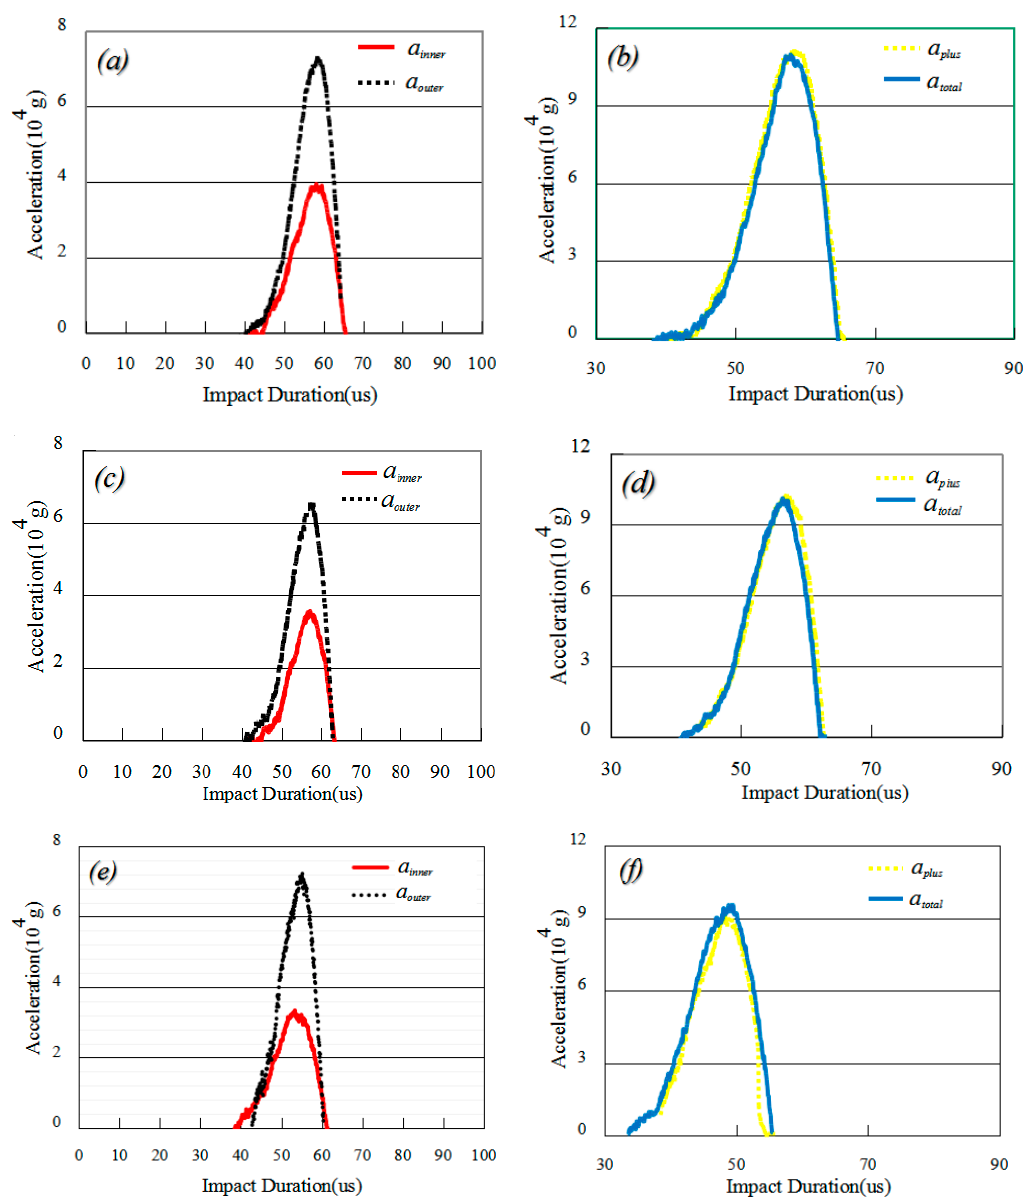
Figure 5. Experimentally determined accelerations under impacts from the inner ( a inner , solid lines ) and outer ( a outer , dotted lines ) bullets as functions of impact duration, as detected by the Doppler frequency shift of the mounted base. ( a ), ( c ), and ( e ) show the cases impacted by the bullets separately; ( b ), ( d ), and ( f ) show the cases impacted by both bullets simultaneously ( a total , solid lines ). The dotted lines in ( b ), ( d ), and ( f ) represent the sums of the accelerations ( a plus ) of the inner and outer bullets in ( a ), ( c ), and ( e ), respectively.